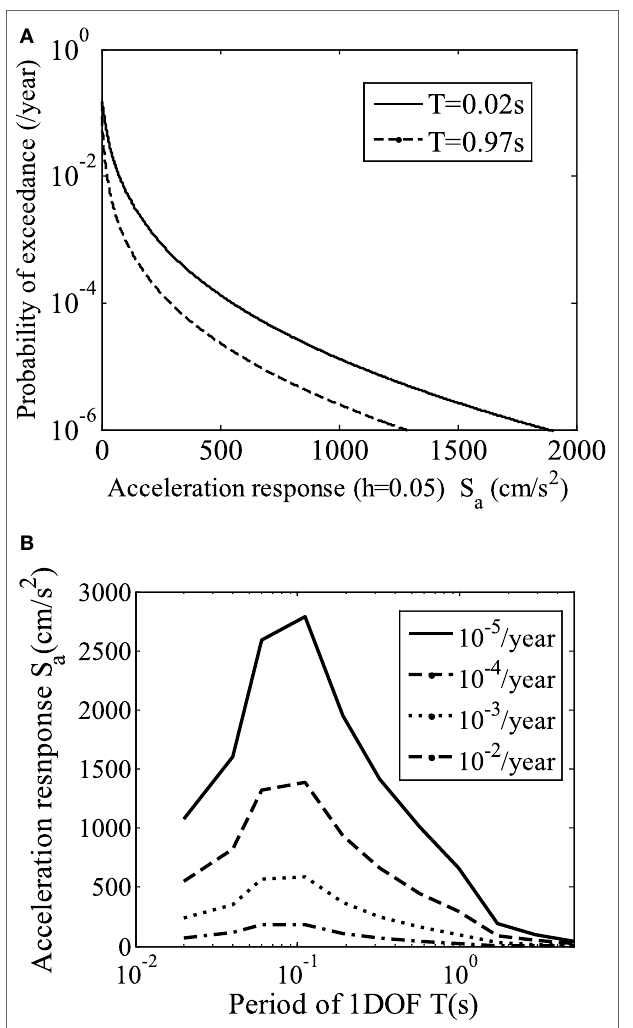
FIGURE 5 | Most probable acceleration response spectrum and the required additional seismic margin required for items important in mitigating the consequences of accidents . (A) Comparison between the most probable acceleration response spectrum and uniform hazard spectra and (B) required additional seismic